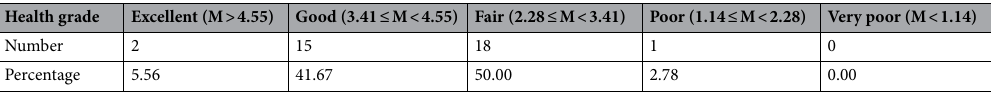
Table 6. B-IBI health assessment grade of sampling